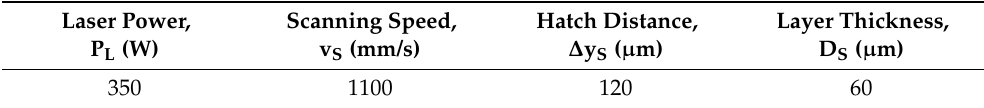
Table 2. LPBF process parameters for sample manufacturing